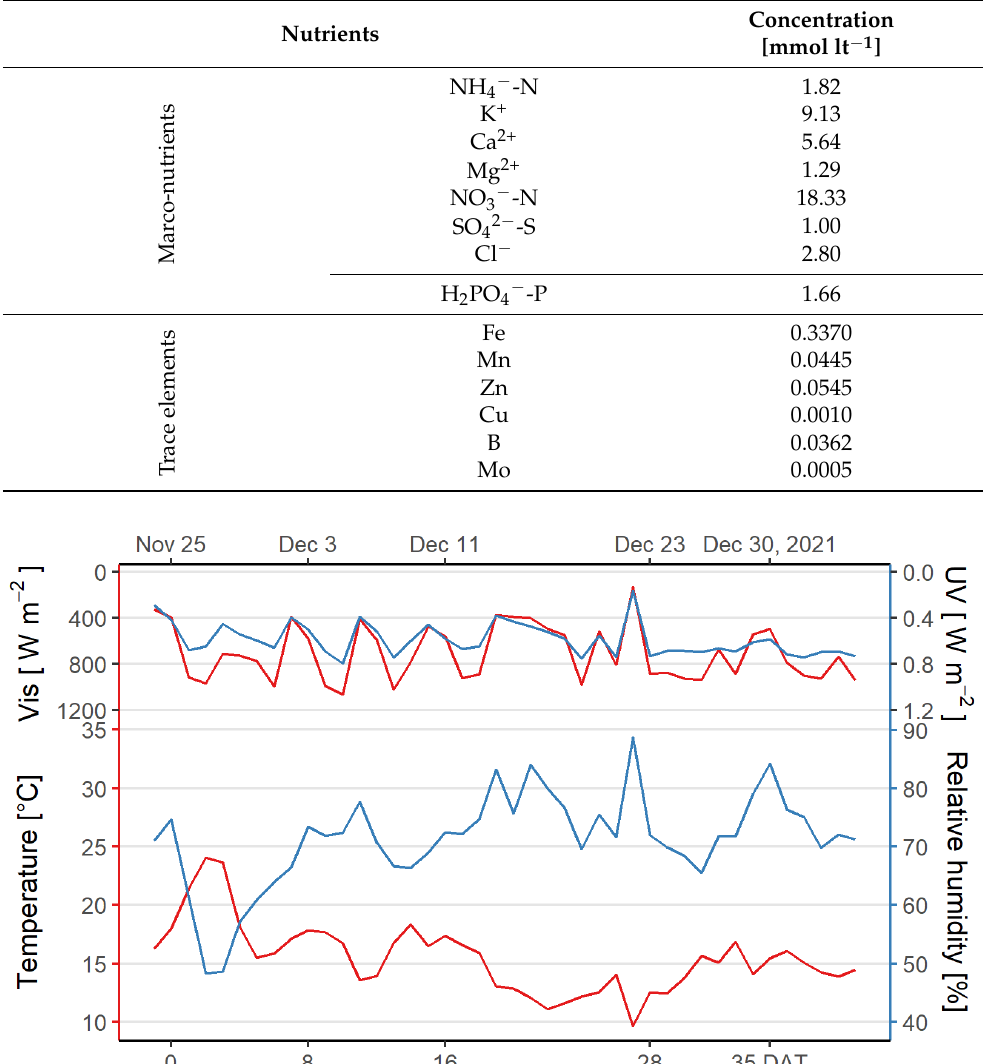
Table 3. Nutrient concentration in the nutrient solution (NS).